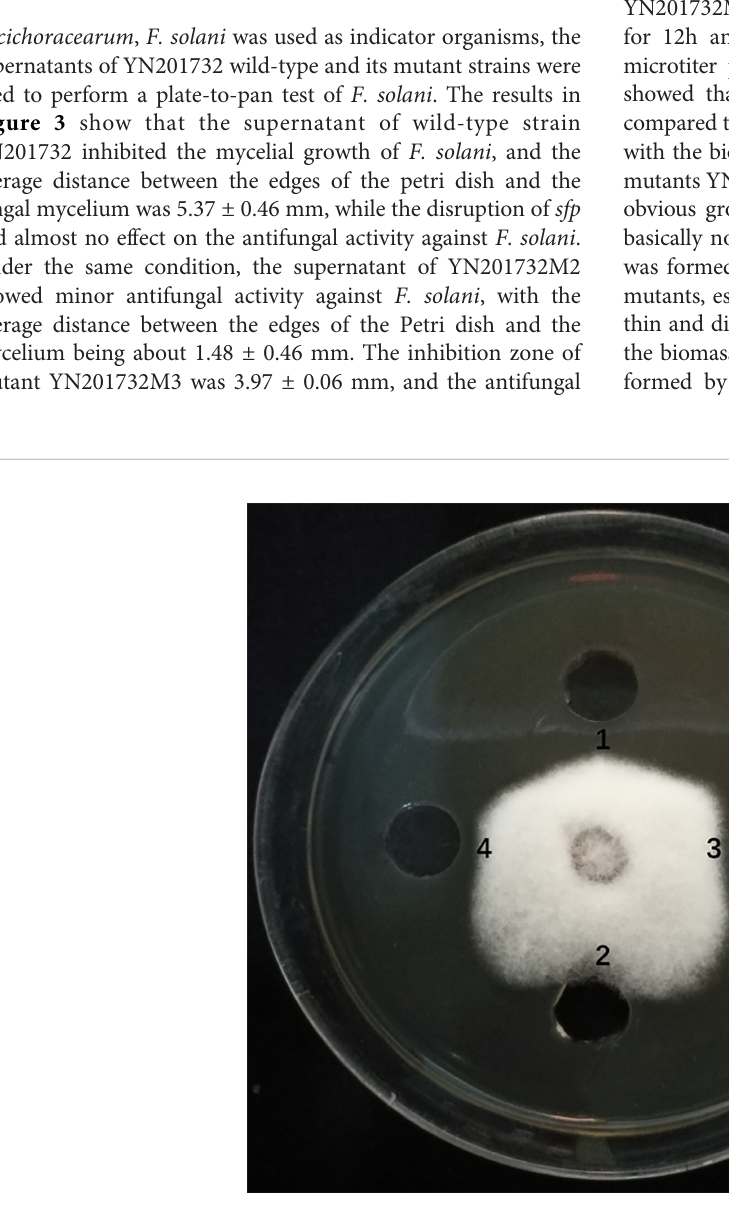
FIGURE 3 | Antagonistic effects of supernatant drawn from B. amyloliquefaciens wild type strain YN201732 (spot 1), the sfp-disrupted mutant strain YN201732M1 (spot 2), the bmyA-disrupted mutant strain YN201732M2 (spot 3), and the fenB-disrupted mutant strain YN201732M3 (spot 4) against the indicator organisms ( F. solani ). A volume of 100 m L of a 48h culture grown in Landy medium was dropped into the hole (5mm) on PDA agar plates with actively growing F. solani . The plates were incubated at 25°C for 5